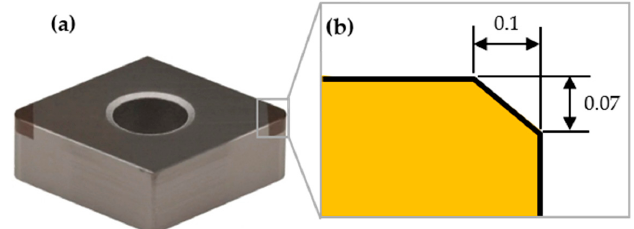
Figure 2. Geometric parameters of the chip breaker: Land width (a), tool-chip contact length (L), rake angle ( α ), radius of curvature ® and groove width (W).